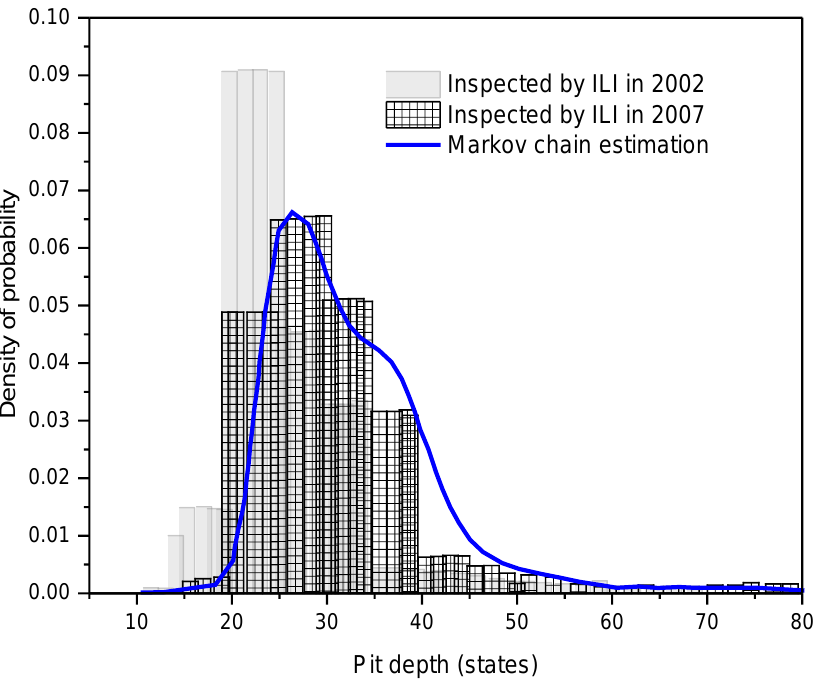
Figure 9. Results of the Markov chain modeling of pitting corrosion evolution from two recurrent inspections according to the research work led by Caleyo and Velázquez. Modified and turned into color using information presented in [71].